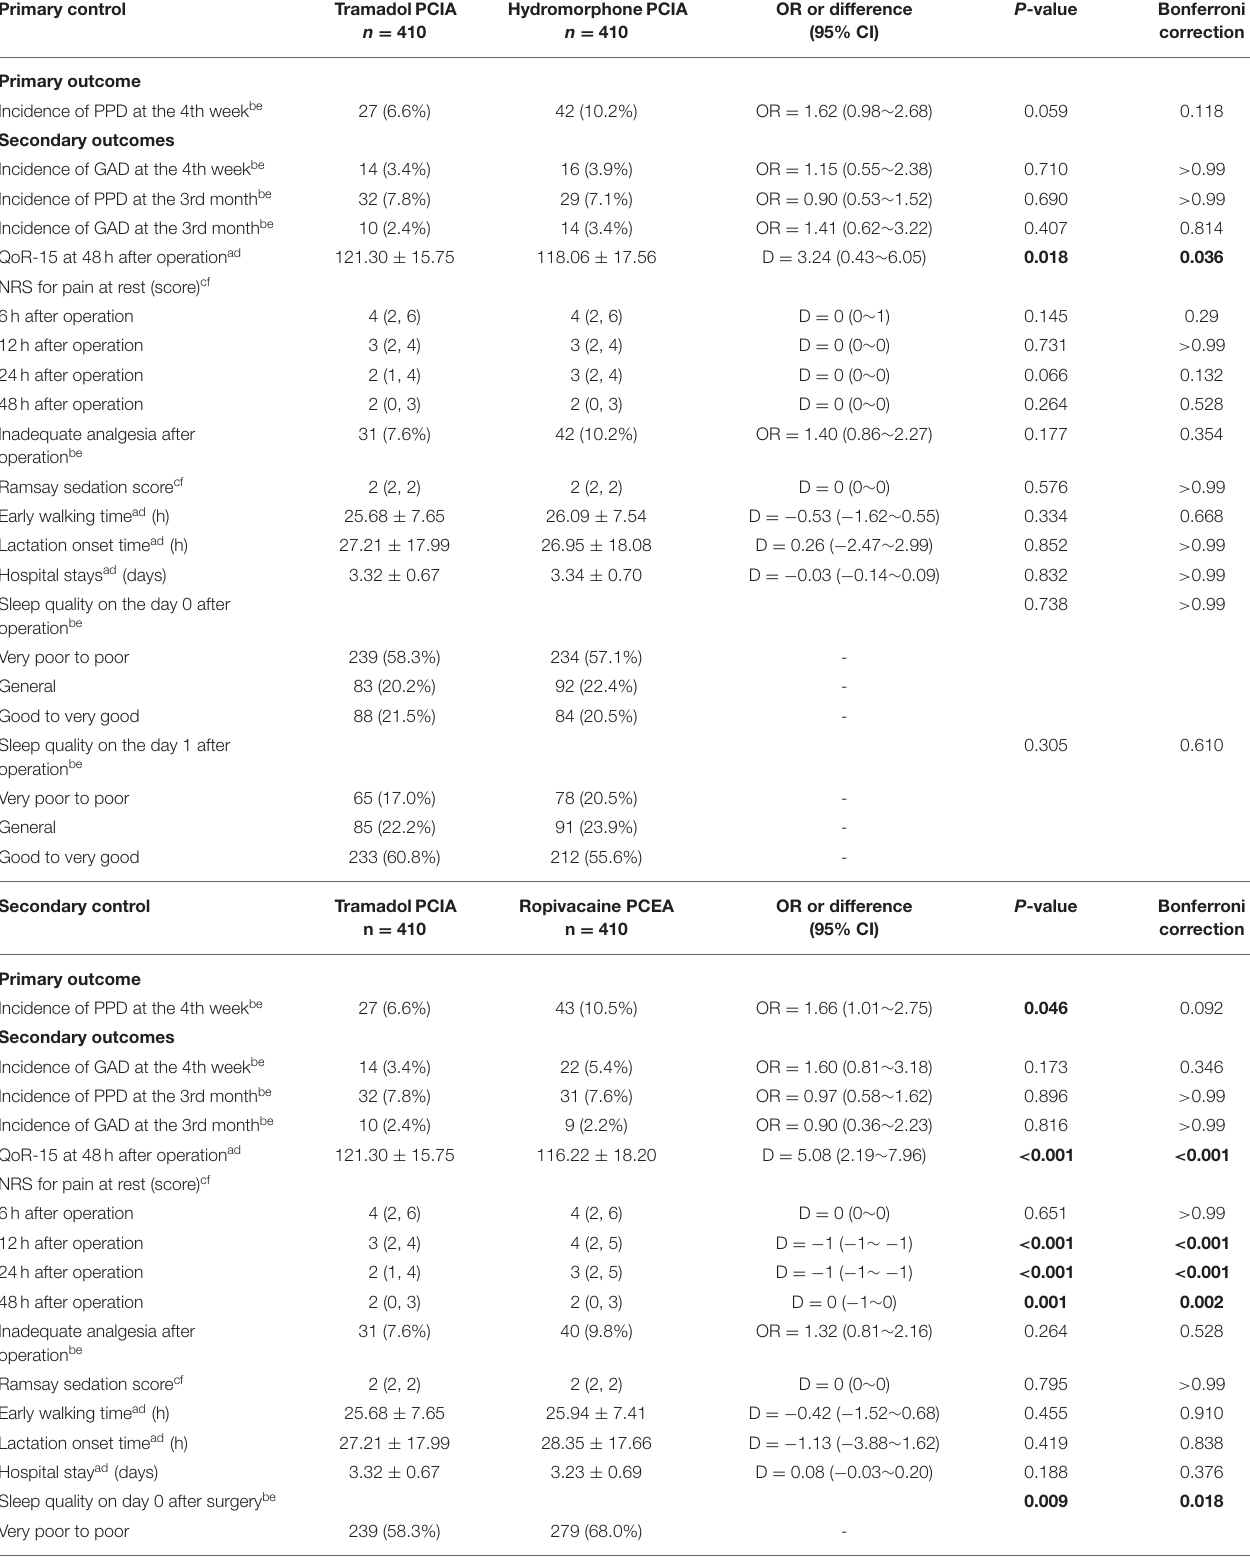
TABLE 2 | Primary and secondary outcomes of tramadol group compared to control groups. Primary control TramadolPCIA